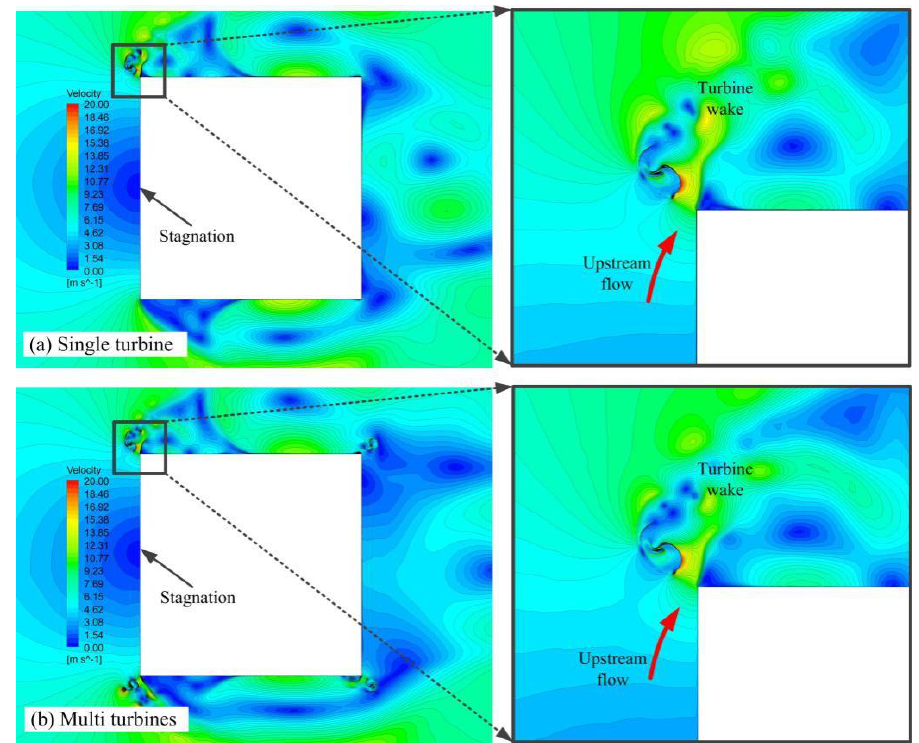
Figure 16. Contours of velocity at l = 0.75 D , TSR = 1.0, φ = 45° and θ = 120°.